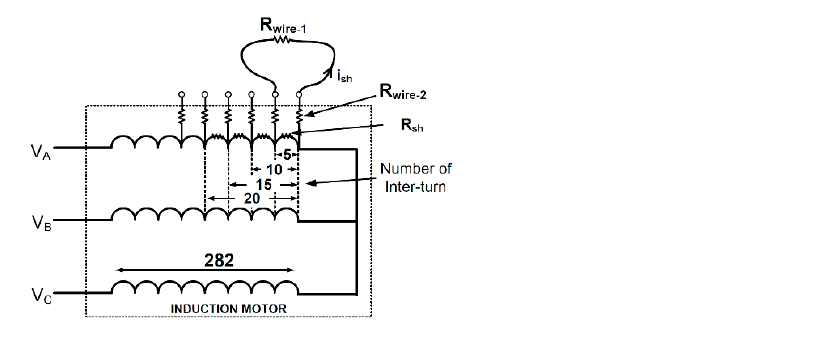
Figure 5. The modified stator winding configuration of the test motor and the external connection circuit used to introduce shorted turn faults (the motor windings have 282 series turns per phase).